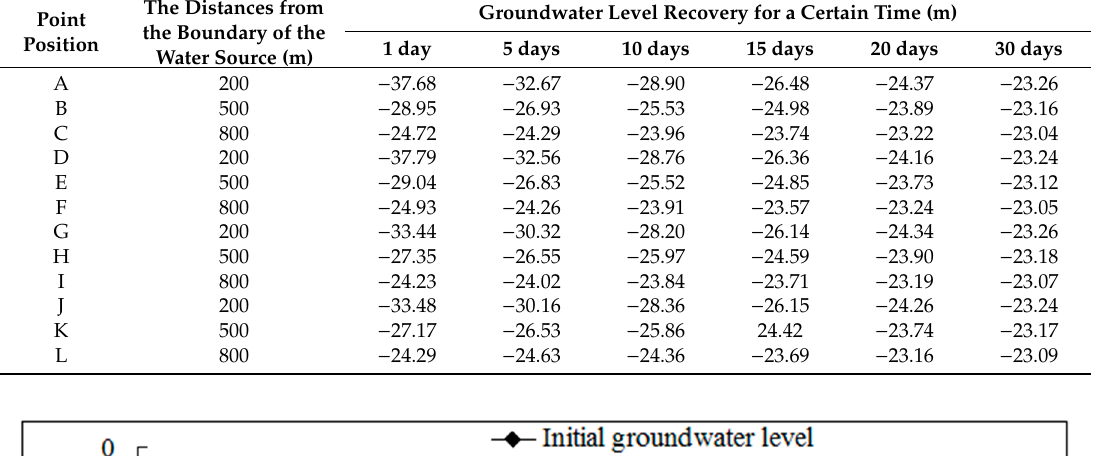
Table 6. Statistics of groundwater level changes around the water source during water level recovery. Point Position